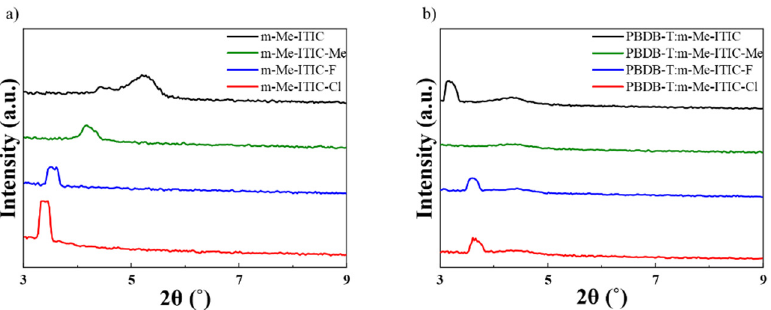
Figure 4. XRD patterns of ( a ) m-Me-ITIC, m-Me-ITIC-Me, m-Me-ITIC-F, and m-Me-ITIC-Cl films, ( b ) PBDB-T: m-Me-ITIC, PBDB-T: m-Me-ITIC-Me, PBDB-T: m-Me-ITIC-F, PBDB-T: m-Me-ITIC-Cl ( b ) PBDB-T: m-Me-ITIC, PBDB-T: m-Me-ITIC-Me, PBDB-T: m-Me-ITIC-F, PBDB-T: blend films. List of Tables.